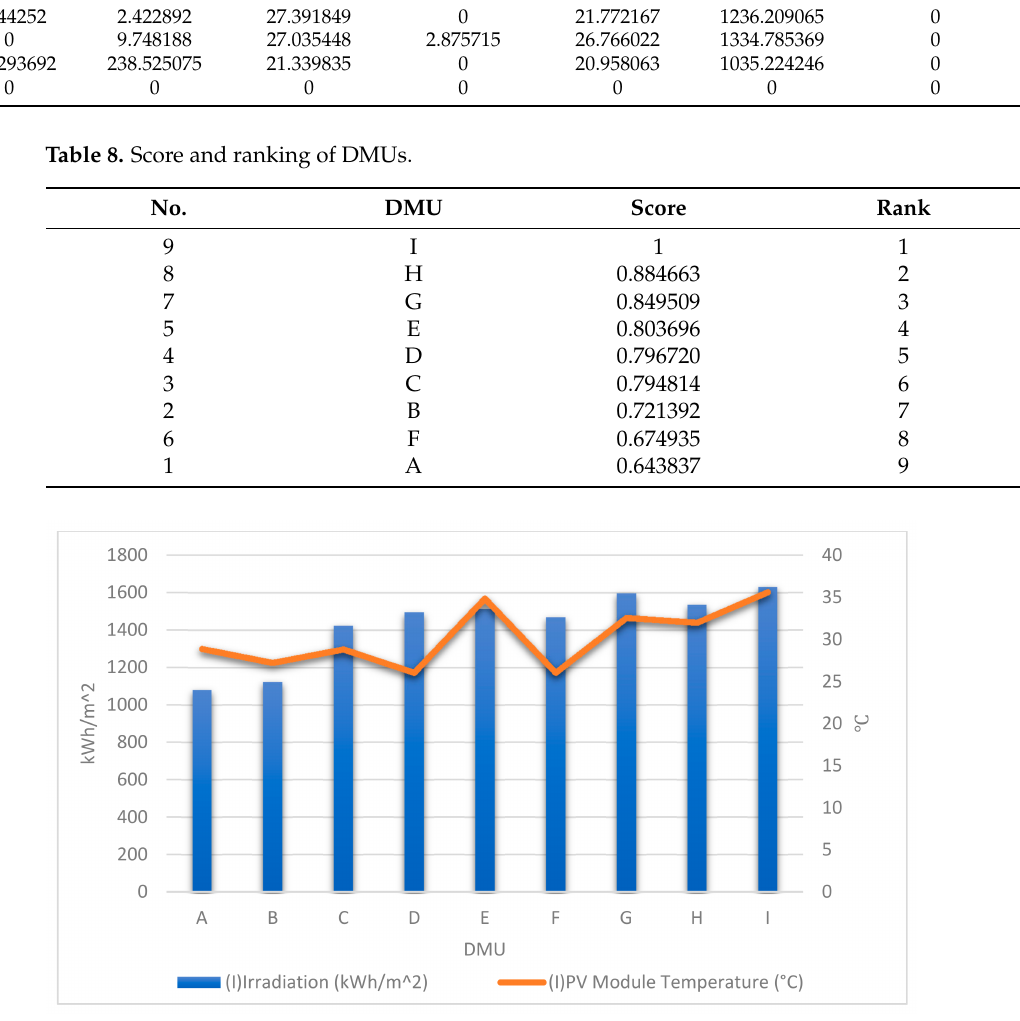
Figure 3. Solar irradiation and PV module temperature with regards to DMUs in 2020. The generated energy from January to December of the nine DMUs is shown in Figure 4; the accumulated energy of the nine DMUs that was lower than 400,000 kWh were produced during November and December, the totals higher than 400,000 kWh